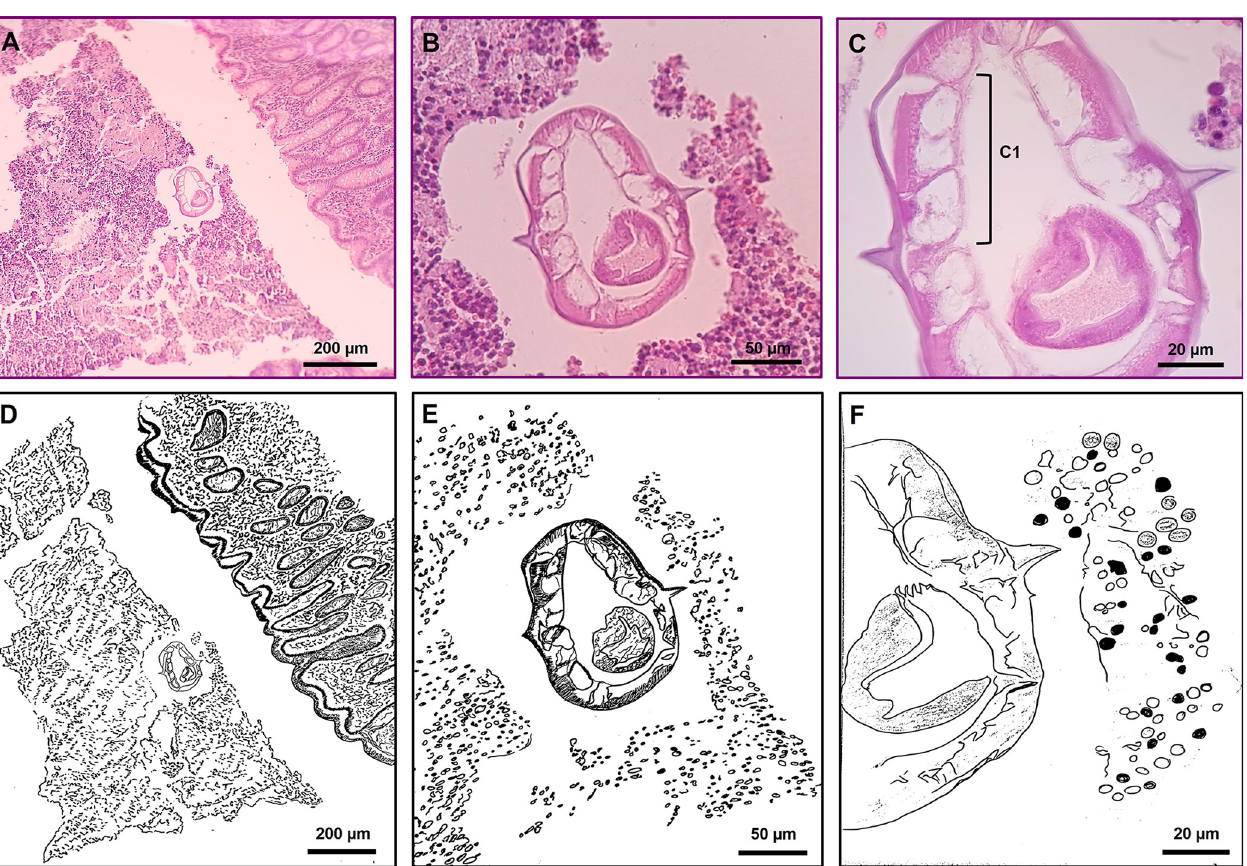
Fig 1. Microscopic images of the cross-section of E . vermicularis in the appendix lumen in different magnifications (A, B, and C). Arrows illustrate the cephalic alae located bilateral and symmetrically in the sections. Images were drawn with camera lucida, Enterobius vermicularis cross-section in tissue sections emphasizing cephalic alae (D, E, and F). C1: Flattened and less than five somatic muscles in each quadrant in cross-section indicated platymyarian and meromyarian types of the somatic muscle.